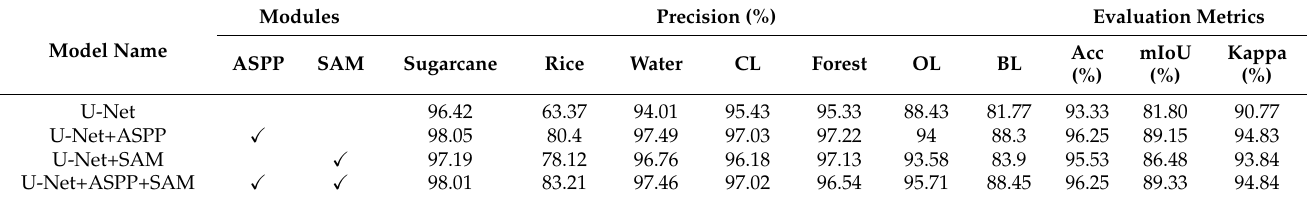
Figure 9. Comparison of segmentation results before and after using ASPP and SAM in U-Net framework. Table 4. Ablation experiment of the proposed modules on the dataset